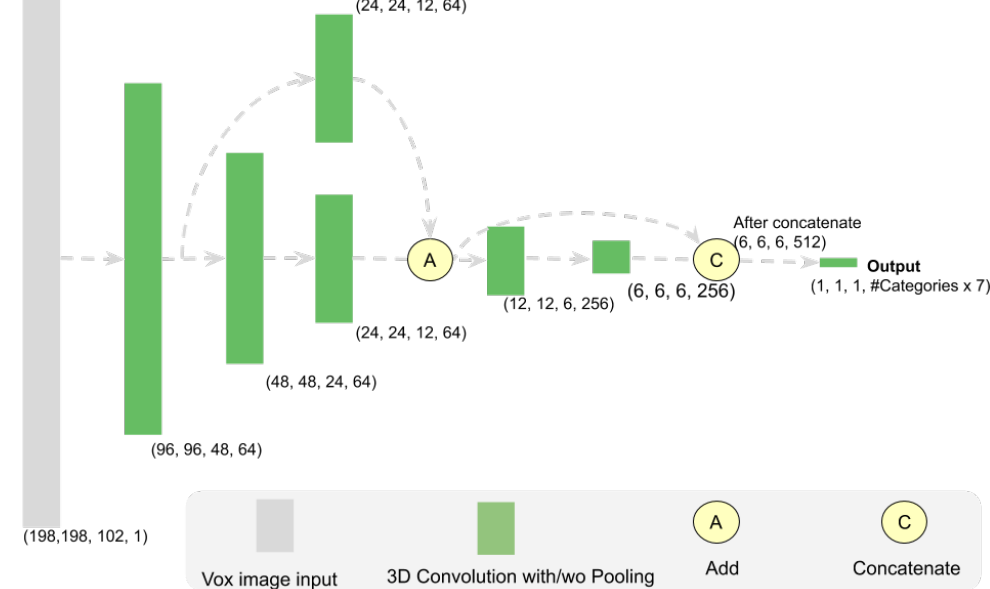
Figure 6. ResnetFCN6 architecture (used for large short scale). Every 3D CNN layer will be followed by a dropout layer. The tensor shape shown here is the output shape of each block. It provides the (width, depth, height, channel) information of the network. The other three scale networks have the same structure with different input size as shown in Table